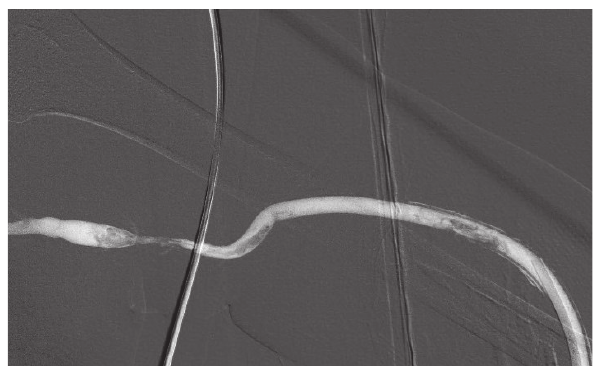
Fig. 1. Confirmed VAG stenosis after thrombectomy using Fogarty catheter.